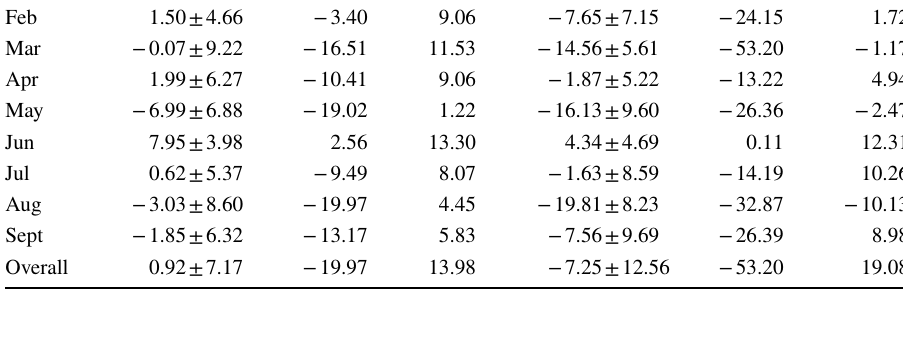
deviation and range of the TSI deviations between seasons